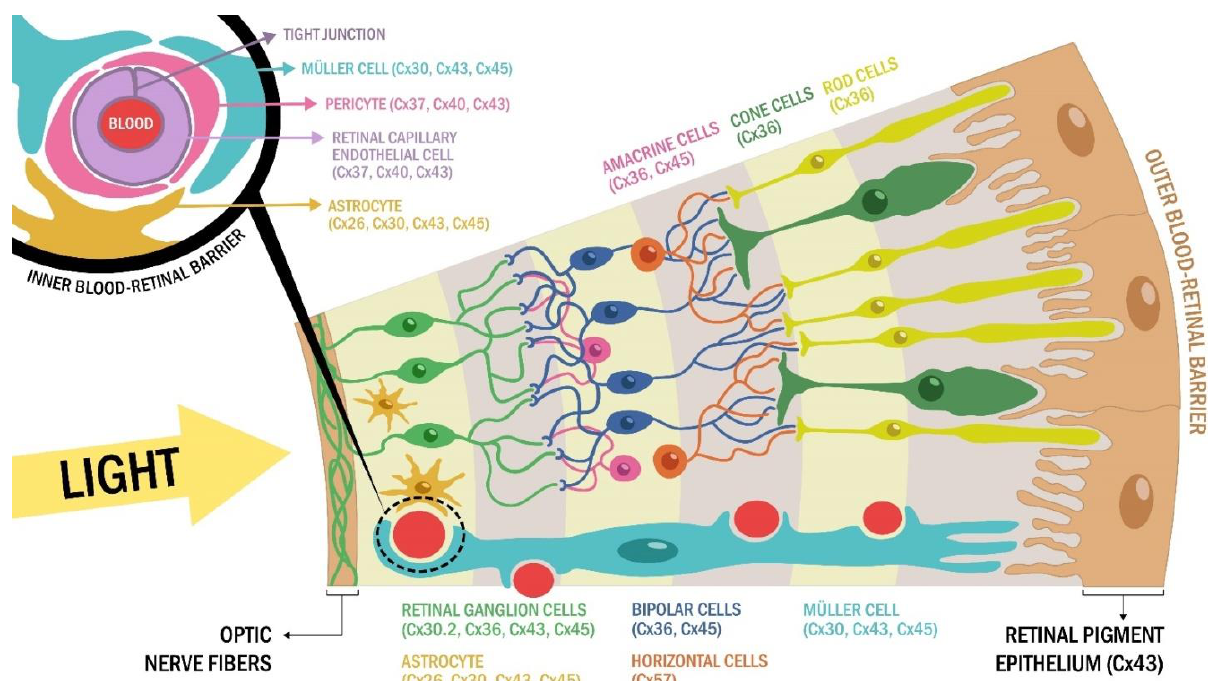
Figure 1. Connexin diversity in the adult retina. The retina is composed of neurons (cone and rod photoreceptors cells, horizontal cells, amacrine cells, bipolar cells, and retinal ganglion cells) and glia cells (Müller cells, microglia and astrocytes) arranged in different layers. Connected with each other, these cells form a complex circuit that converts light into electrical information in the brain. Briefly, light exposition hyperpolarizes photoreceptors (cone and rod cells) synapsing with bipolar cells. This electrical response is then propagated to retinal ganglion cells, whose axon projections makes up the optic nerve, transmitting the information to the brain. Because horizontal cells and amacrine cells mediate negative modulation of this circuit, the final retinal ganglion signal output corresponds to the net result of both excitatory (bipolar cell) and inhibitory signals (mainly amacrine cells). The main strategy for retinal signal transmission is electric transmissions, through gap junction intracellular communication (GJIC). These same GJIC are key players in the vascular function of the retina. In effect, retinal neurons coupled together with blood retinal barrier components (including retinal endothelial cells and retinal pigment epithelium) express diverse connexin proteins.